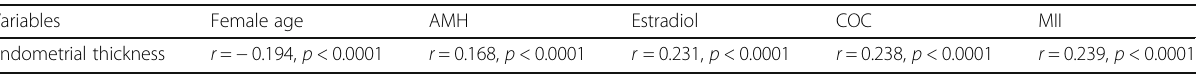
Table 5 Correlation of endometrial thickness with different clinical parameters Variables Female age AMH Estradiol COC MII Endometrial thickness Correlation was significant at 0.01